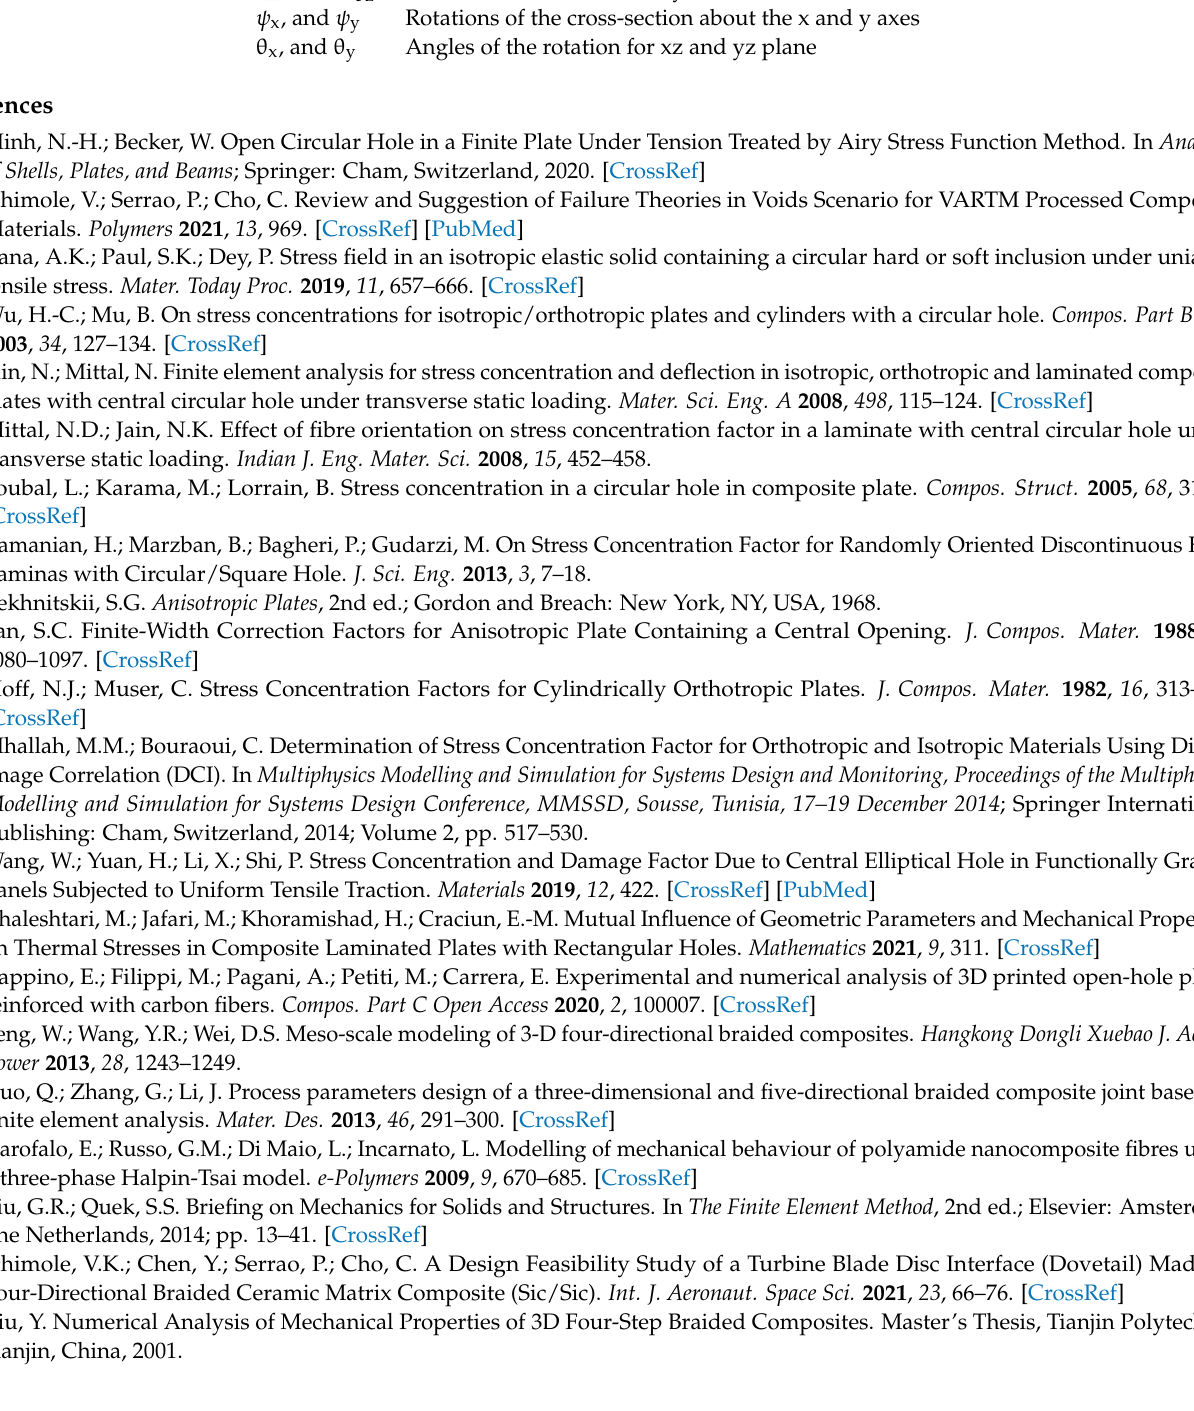
Table 2. Transverse shear stress and SCF for a braided polymer